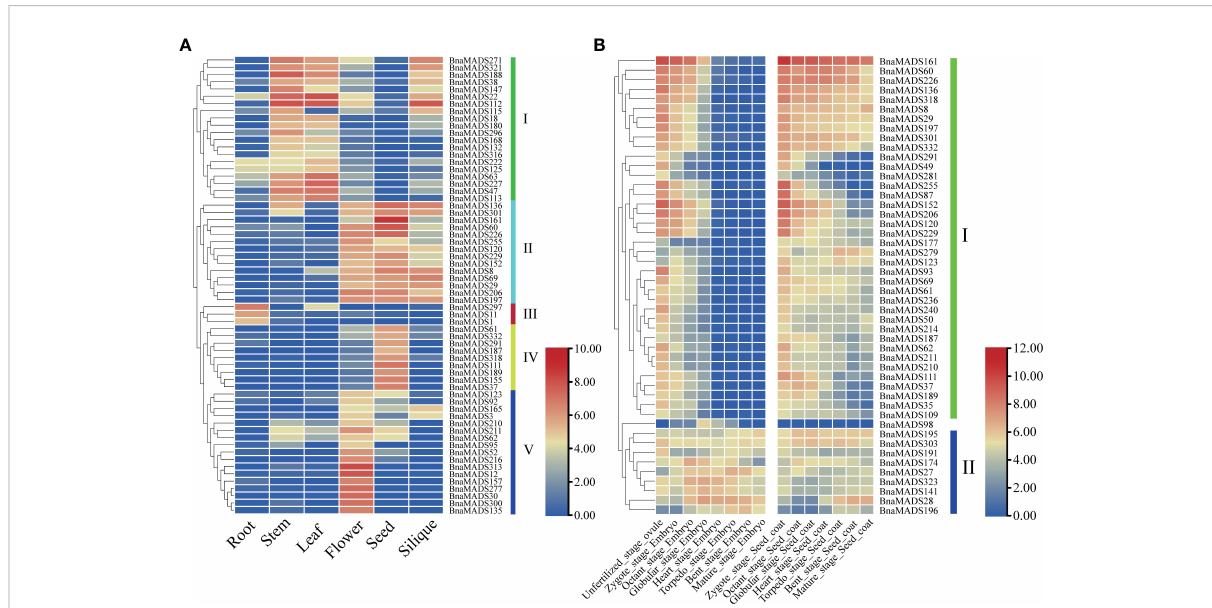
FIGURE 5 Expression patterns of MIKC-type MADS-box genes in different tissues and developmental stages. (A) Heatmap of TPM values in six different tissues (root, stem, leaf, fl ower, seed, and silique). (B) The gene expression trends during different unfertilized ovule, embryo, and seed coat